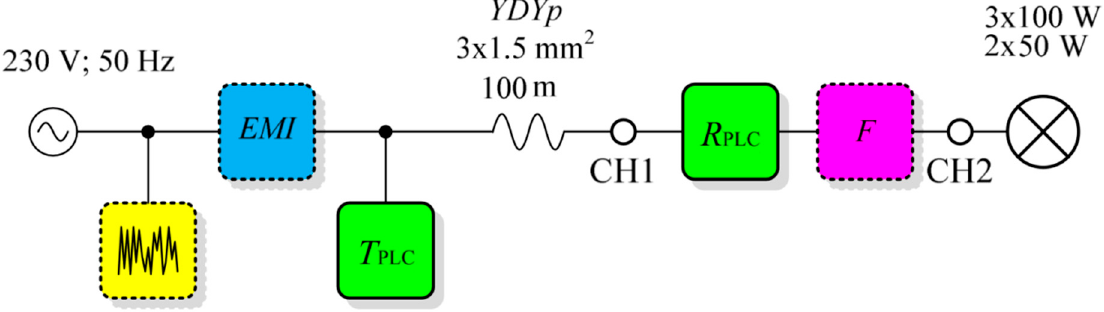
Figure 11. Connection schematic of the model with an EMI filter and without an additional receiver connected in the middle of the line—Variant 1.